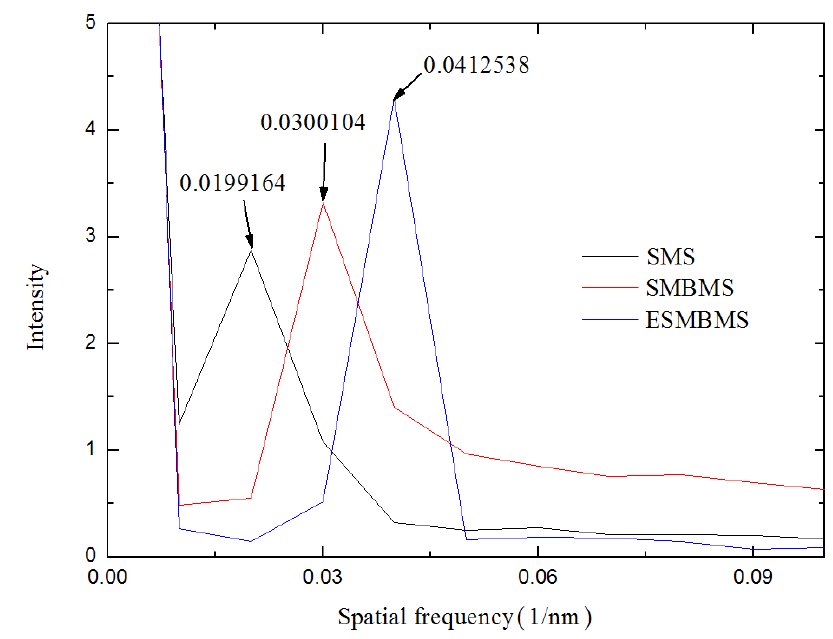
Figure 10. Spatial frequency spectra of the MZIs with different lengths.